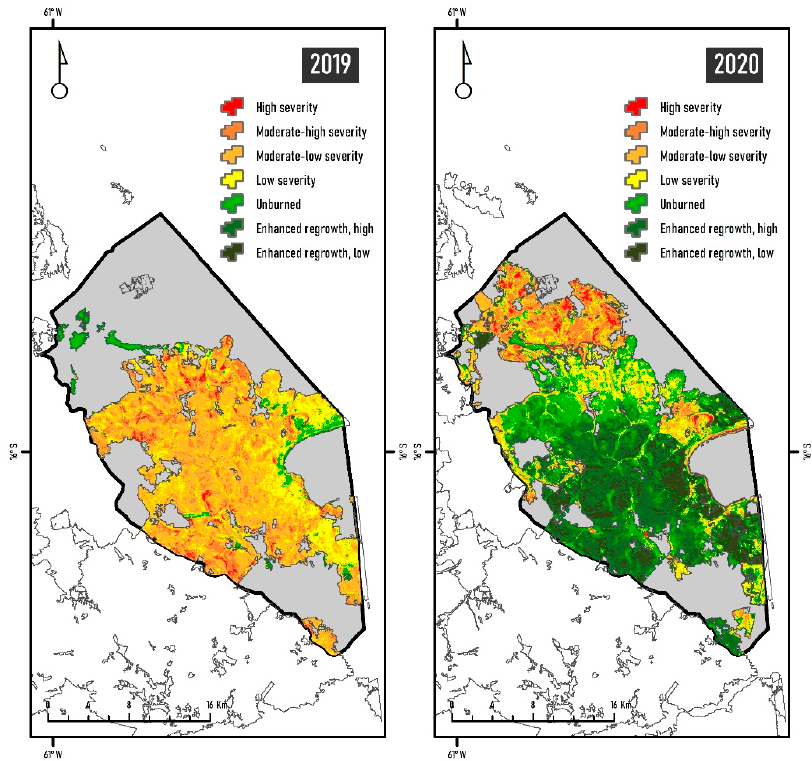
Figure 6. Fire severity levels based on dNBR at Copaibo between 2019 and 2020.